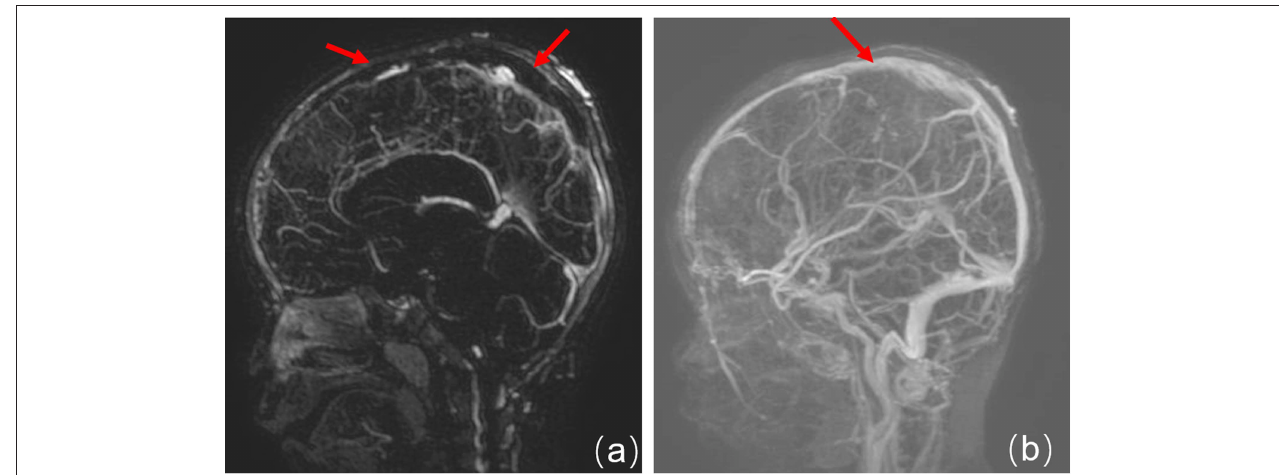
FIGURE 2 | Enhanced MRV. (a) Before treatment, the superior sagittal sinus is not filled and shows a long strip filling defect. (b) At 5 months after treatment, the imaging shows the upper sagittal sinus development and local irregularities.